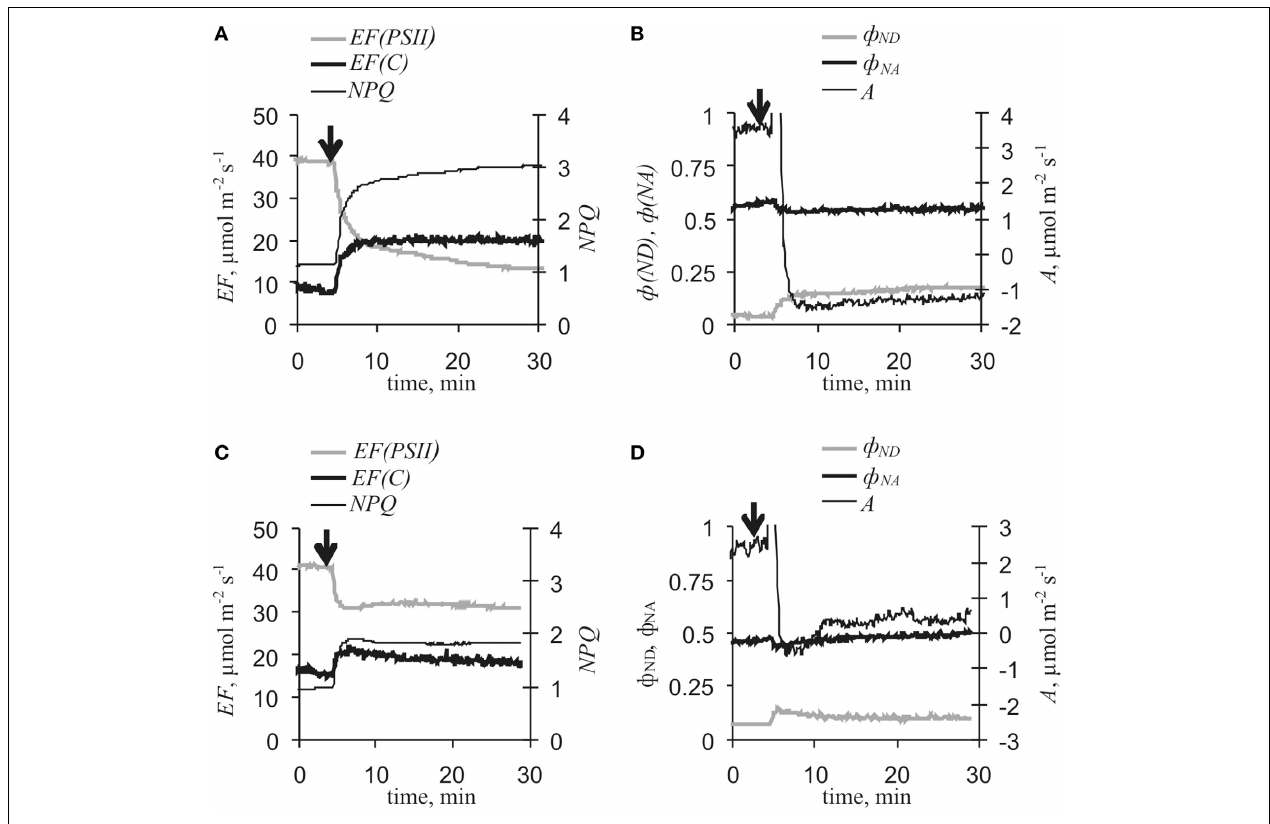
[CO 2 ]-lowering to 10–15ppm. (C) EF(PSII) , EF(C) and NPQ under [CO 2 ]-lowering to 150ppm. (D) φ ND , φ NA , and A under [CO 2 ]-lowering to 150ppm. Initial [CO 2 ] was 360ppm. Arrow, start of [CO 2